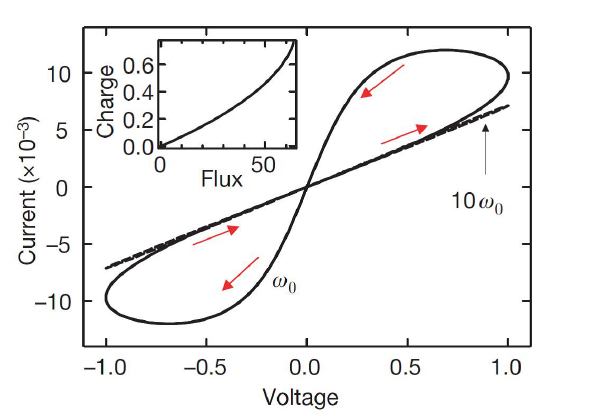
Fig. 6: Typical behavior of memristors. The memristance of the memristor depends on the amount of electric charge that has passed through the device. Consequently, the current is nonlinear with the applied voltage, resulting in hysteresis loops rather than straight lines. If the signal frequency, ω , is sufficiently high, the memristance of the memristor has too little time to respond to the passing charge, resulting in the collapse of the hysteresis loops to straight lines. The inset figure shows that memristors require nonlinear q - φ -plots. Reprinted from Nature with permission